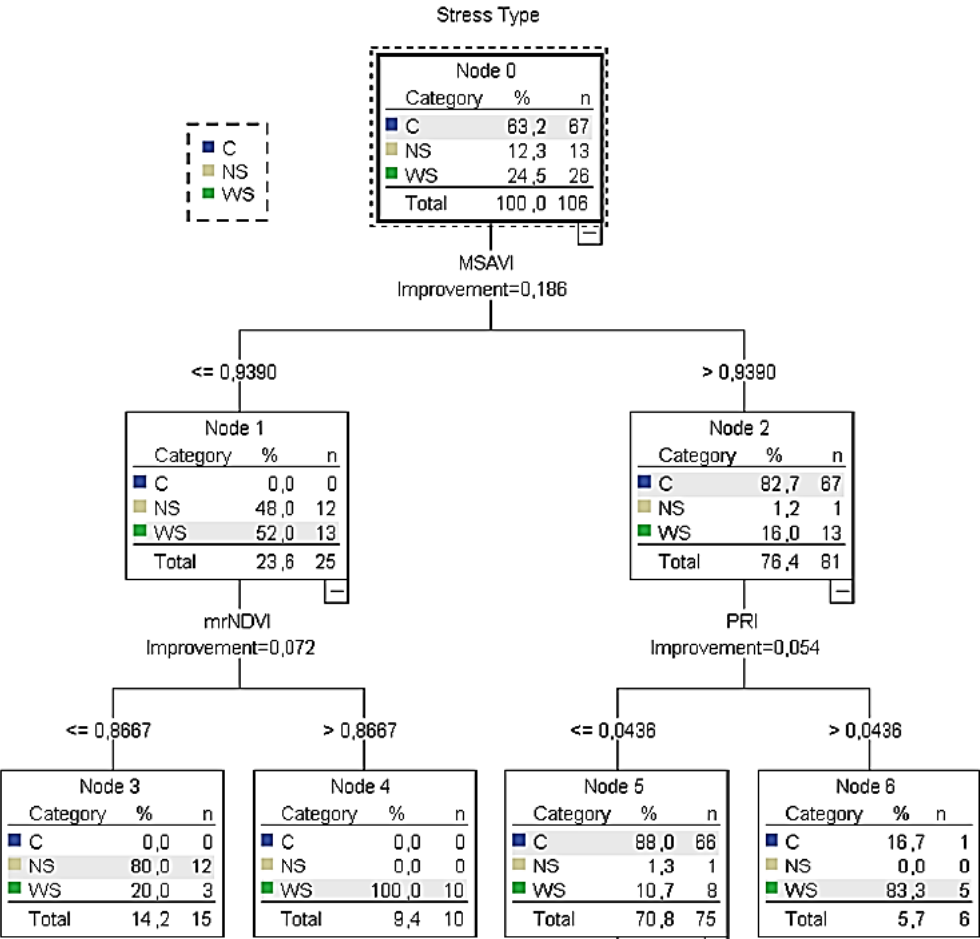
Figure 6. The CT5 classification tree of the training sample for calibration to identify healthy, water- and nitrogen-deficit stressed plants. C : indication of control plants; WS : indication of water deficit stress plants; NS : indication of nitrogen deficit stress plants. stress plants; NS : indication of nitrogen deficit stress